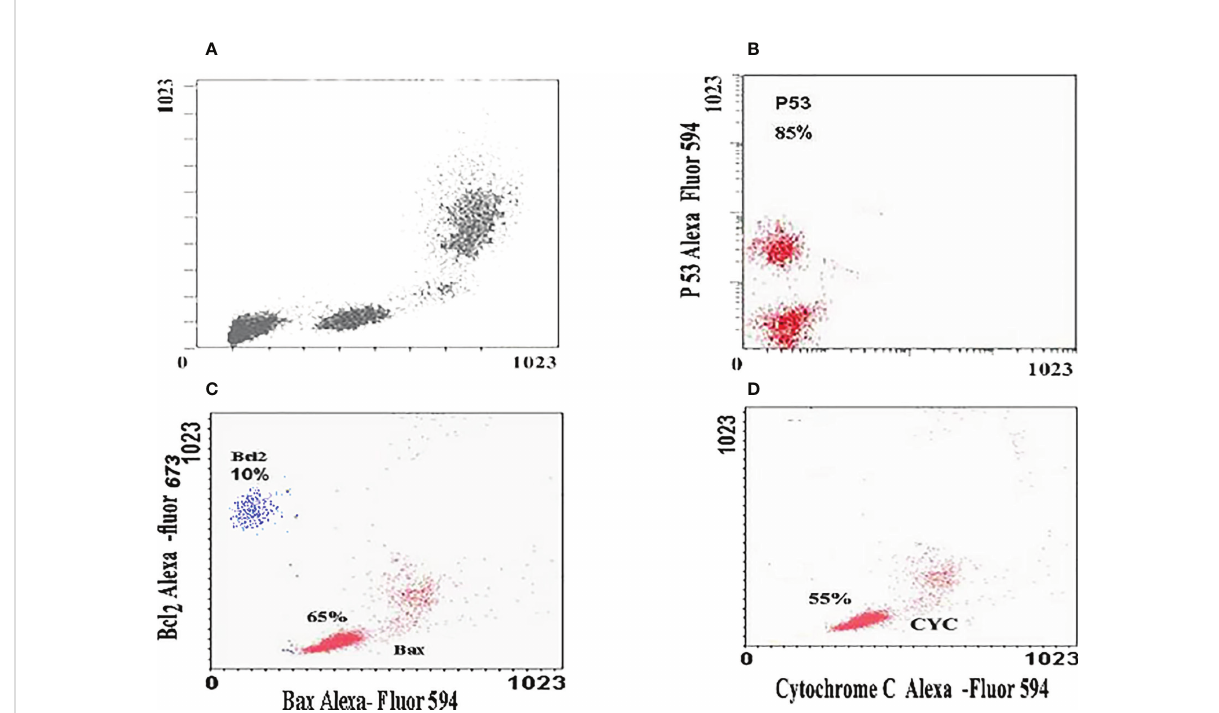
FIGURE 8 Immuno fl orescent images of HuH7 exposed to 100 m g/ml of ZnO nanospheres (ZnO-NS) for 24 hour for up-regulation of P53, Bax, Bcl 2 and Cytochrome C. (A) The immuno fl orescent of huh7 remedied with DMSO (B) The immuno fl orescent of P53 (C) The immuno fl orescent of Bax and BcL 2 (D) The immuno fl orescent of Cytochrome C.